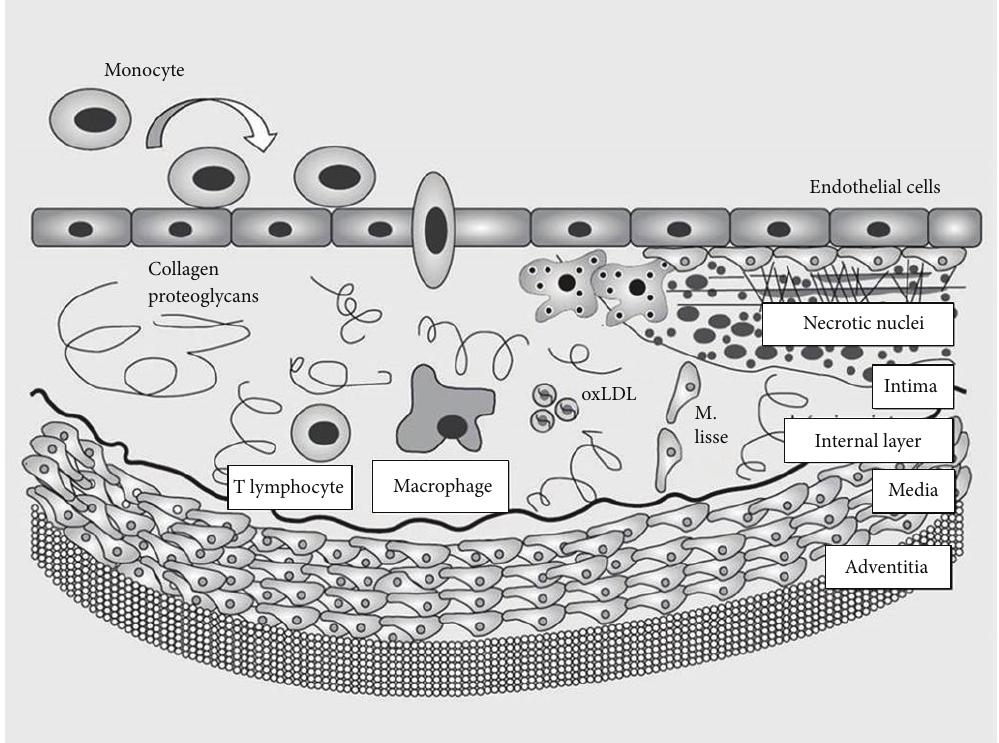
Figure 1: Development of atherosclerotic plaques in obstructive sleep apnea patients, modified from N´acher et al.